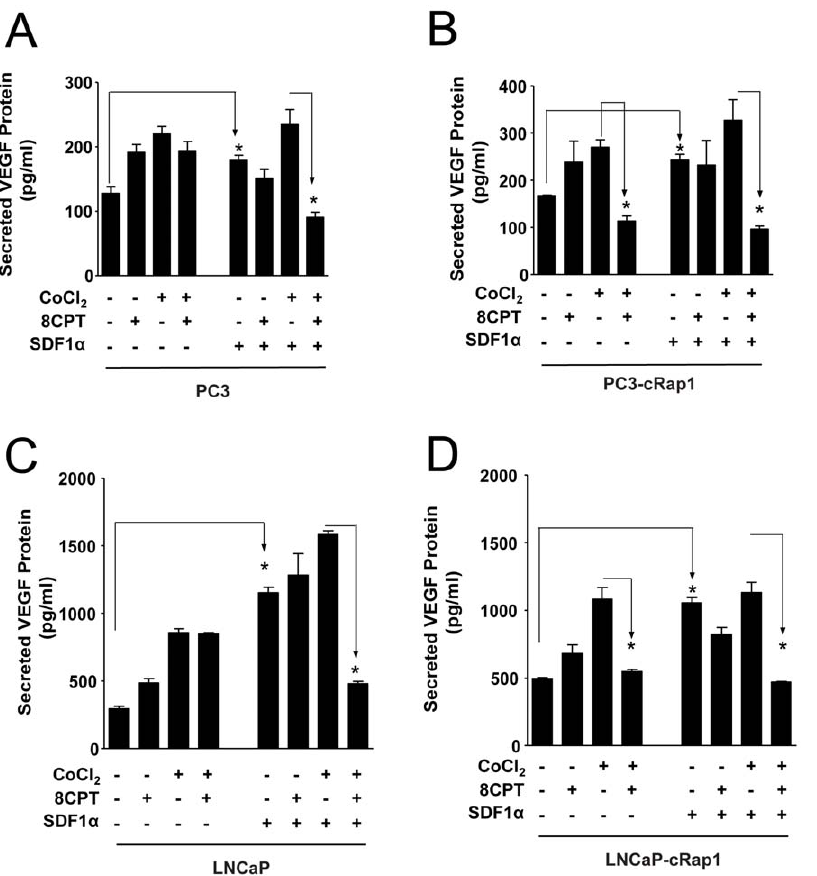
Figure 4. Effect of SDF-1 a on secreted VEGF in prostate cancer cells under hypoxic-like conditions. Cells were treated as indicated and VEGF levels were measured by ELISA as described in Methods. (A and B) PC3 or PC3-cRap1 cells; *p , 0.05, n=3. (C and D) LNCaP or LNCaP-cRap1 cells; *p , 0.05, n=2.